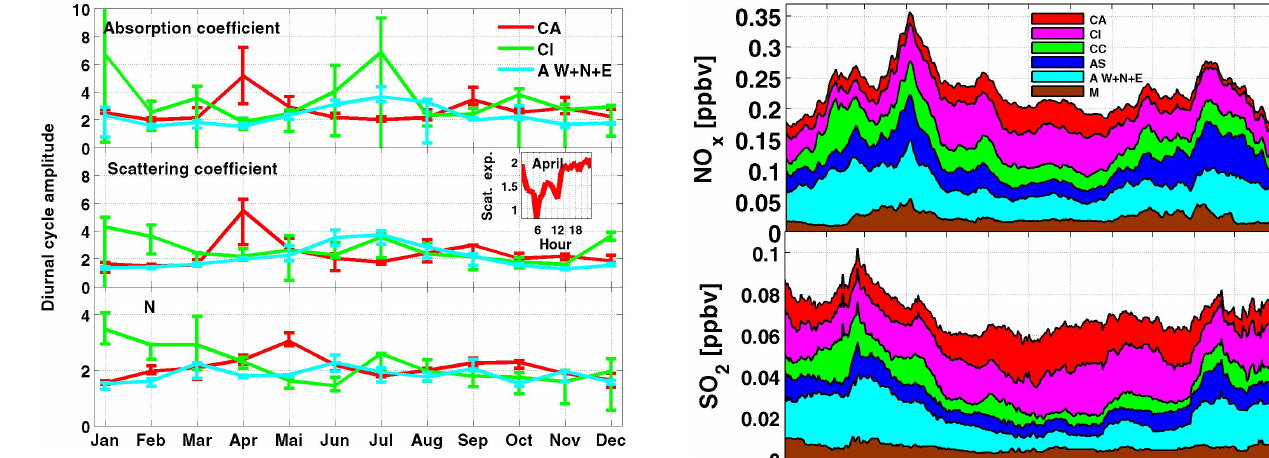
Fig. 7. Amplitude (max/min) of the diurnal cycles of b abs , b scat and N concentration for CA (subsidence), CC (lifting) and advective weather types from W, N and E. Figure 6b inset shows the April diurnal cycle of the scattering ˚Angstr¨om exponent at 550nm. Error bars correspond to non-parametric confidence limits.